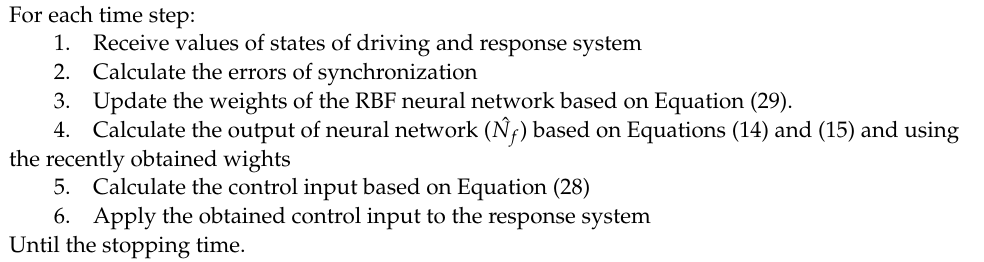
Algorithm 1. RBF neural network-based fault-tolerant active control.